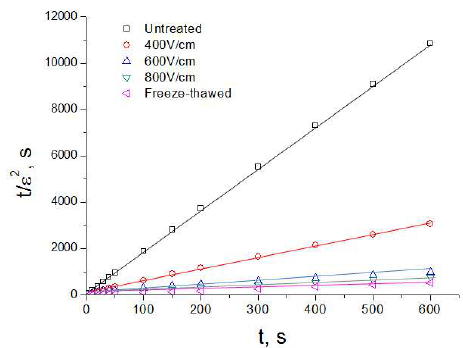
Figure 3. t vs. t for the untreated, PEF treated, and freeze-thawed t ε 2 Figure 3. vs. t for the untreated, PEF treated, and freeze-thawed samples. 2 